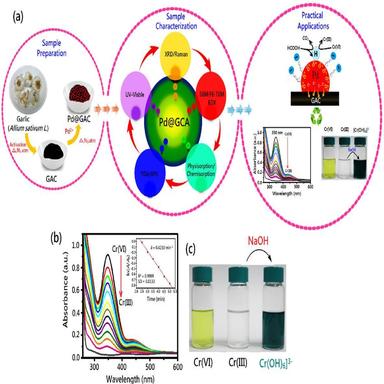
(a) Time-dependent UV/Vis spectra associated with the reduction of Cr(VI) catalyzed in the presence of RuePd@CFAC by FA and (b) The photograph of color change during the Cr(VI) reduction at different time intervals and formation of (3 (green color) after the addition of aqueous NaOH. (For interpretation of the references to color in this figure legend, the reader is referred to the Web version of this article.)